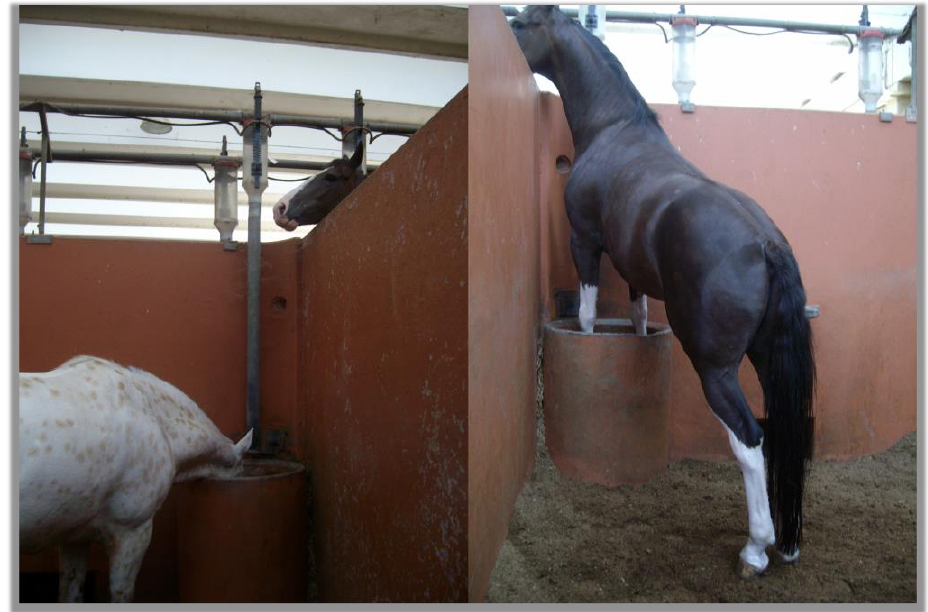
Figure 6. In a barren environment, a stallion (right) searches for social contact with the stallion in a neighbouring box (photo by Aleksandra